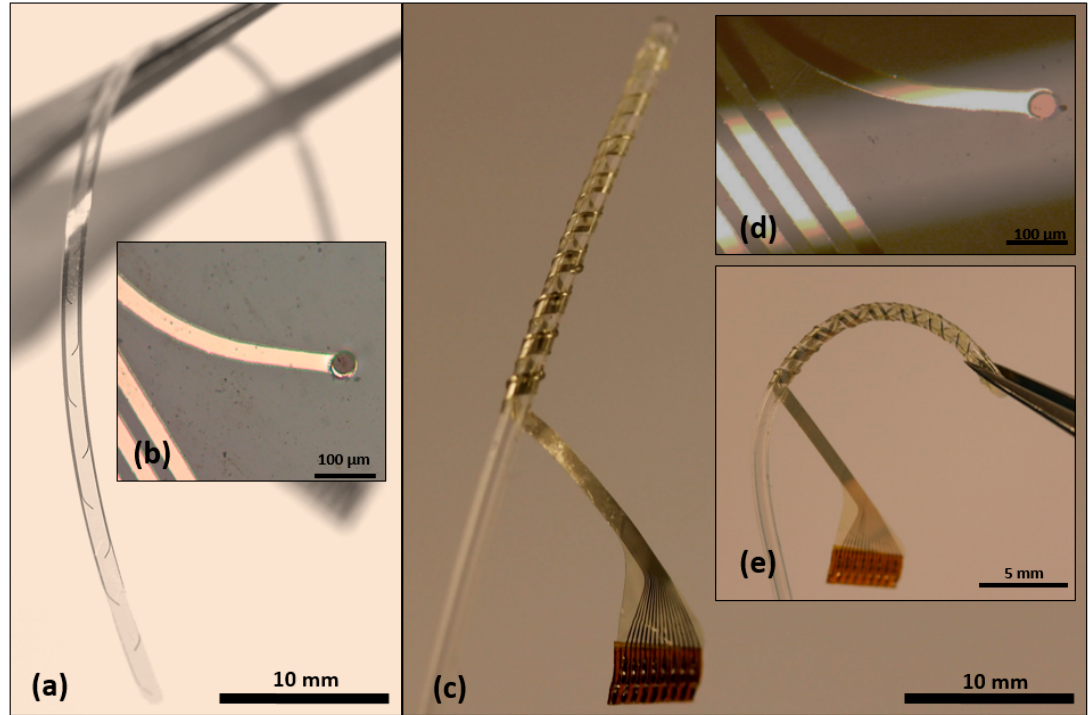
Figure 4. Representation of the fabricated thin-film device and the assembled hybrid probe; ( a ) cleanroom fabricated GC thin-film electrode featuring 16 active channels and zero insertion force (ZIF) interconnection in hybrid assembly; ( b ) a close-up of the thin-film device and the GC sites:, the dark disk-shaped site represent a glassy carbon interface present at the end of the metal tracks; ( c ) the assembled hybrid DBS probe; ( d ) a representative image of the electrode surface after wrapping the thin-film device around the silicone rubber tubing—no deformation/delamination on the glassy carbon interface was observed; ( e ) the hybrid assembly offering a higher stability to the thin-film device by not only introducing more flexibility and also by allowing for stretch without damage.